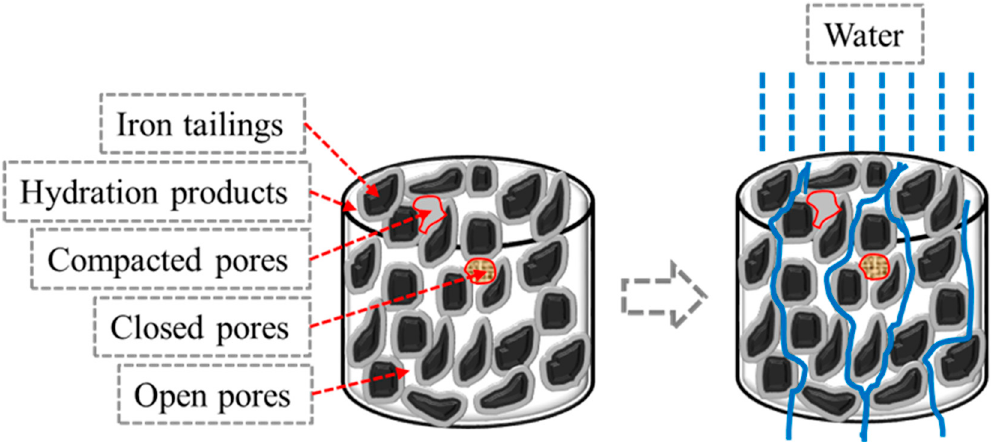
Figure 6. Schematic of the component and structure of pervious concrete.